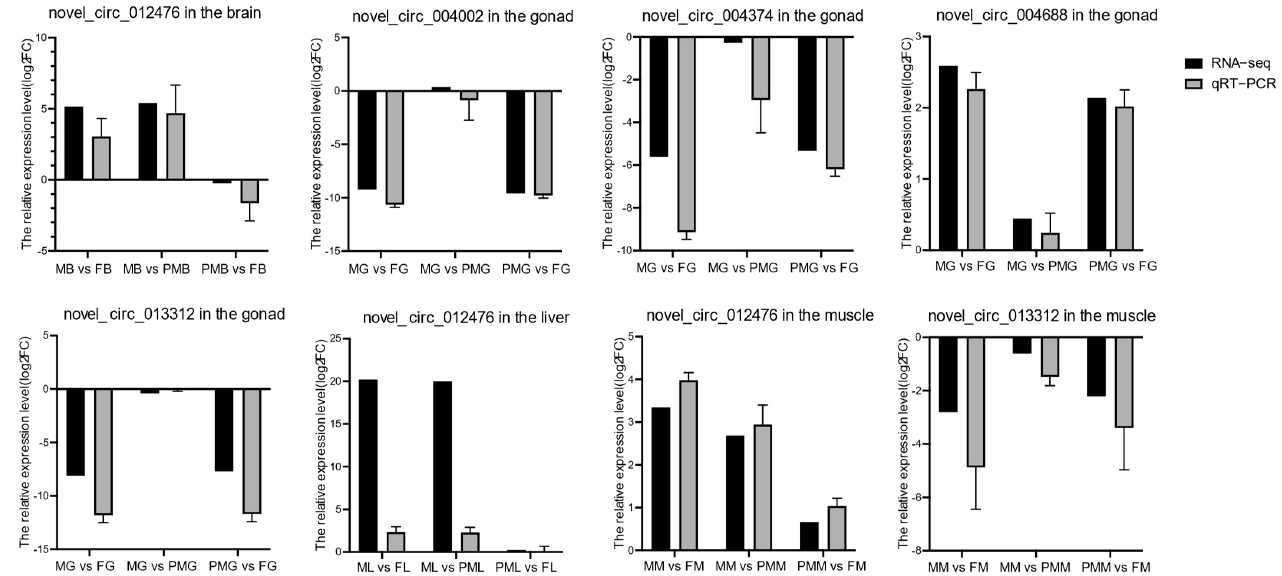
Figure 4. The quantitative PCR (qPCR) verification for the expression patterns of circRNAs. Gray and black legends represent qPCR and RNA-seq results, respectively.